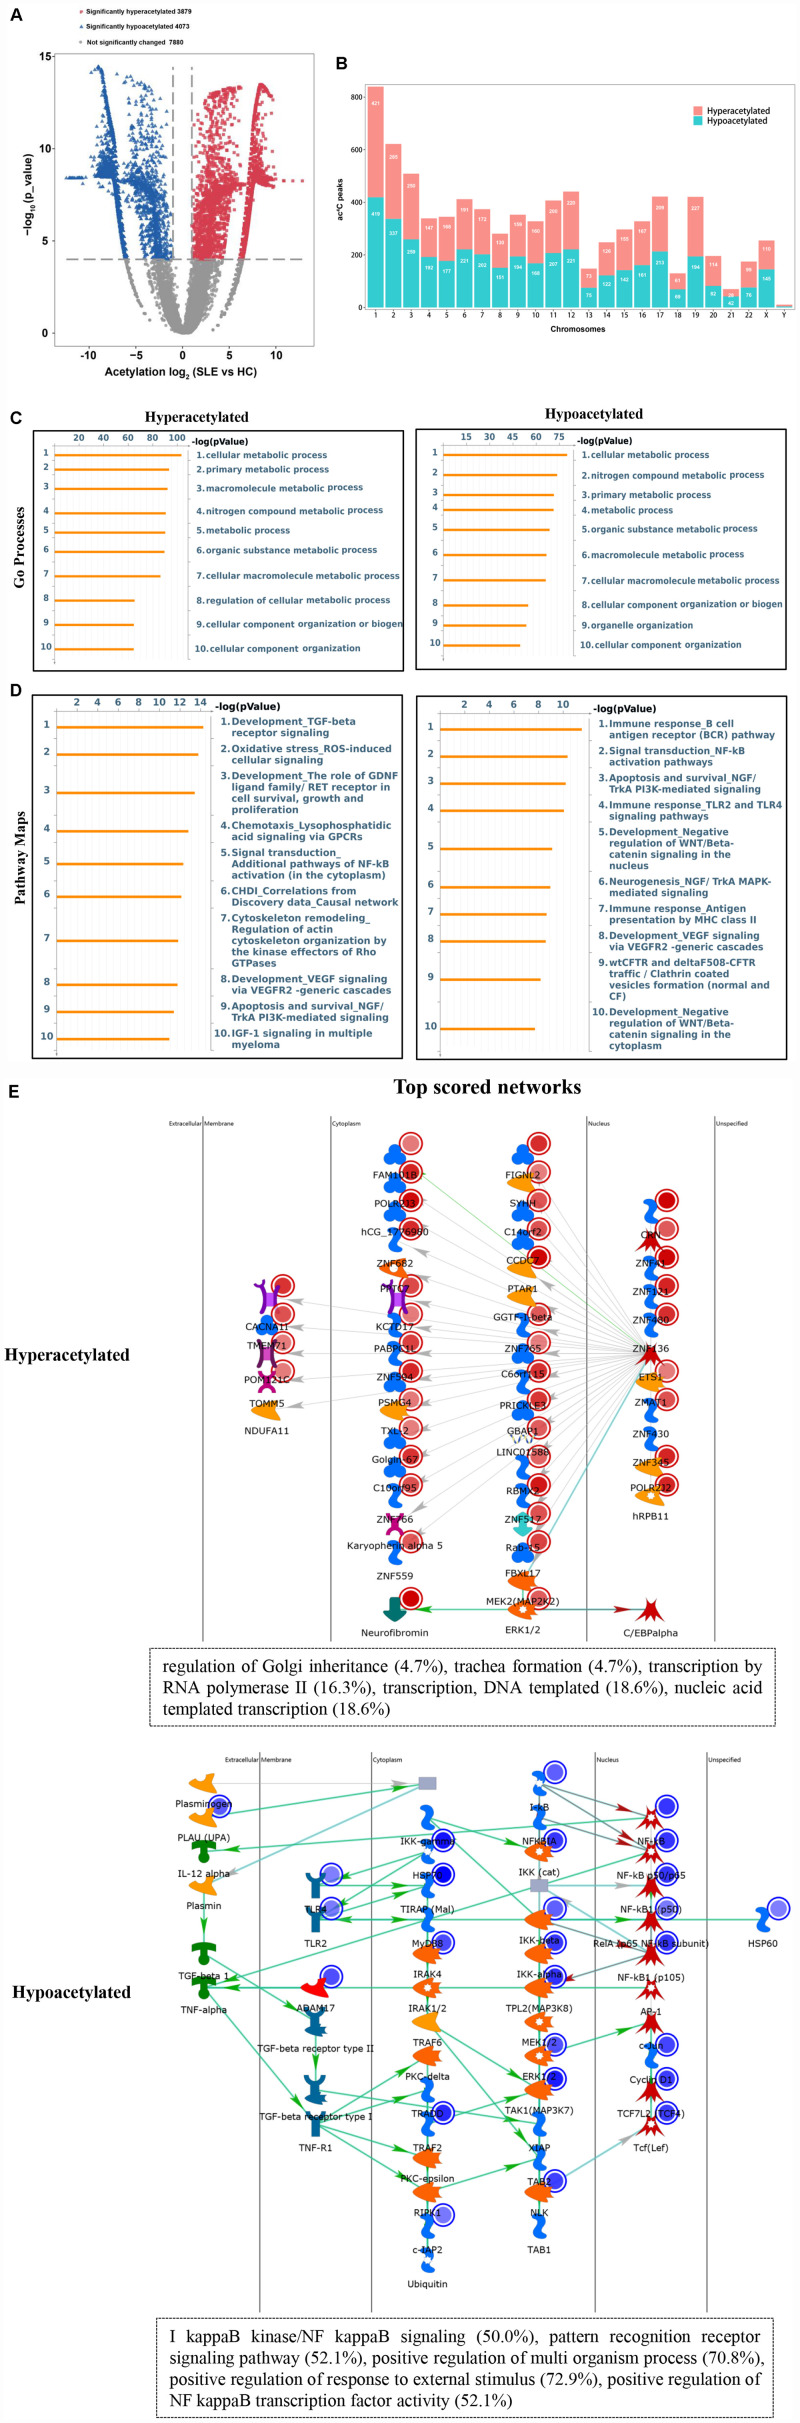
Pathway analysis of differentially acetylated genes. (A) Volcano plots display the differential ac4C peaks with statistical significance (fold change > 2; P < 0.0001). Blue points indicate significantly hypoacetylated transcripts and red points indicate significantly hyperacetylated transcripts. (B) The distributions of altered ac4C peaks in chromosomes of SLE patients. (C) Gene Ontology (GO) process analysis of differentially acetylated genes. Left panel represents hyperacetylated transcripts and right panel represents hypoacetylated transcripts. (D) Pathway Maps analysis of differentially acetylated genes. Left panel represents hyperacetylated transcripts and right panel represents hypoacetylated transcripts. (E) Top scored networks analysis of differentially acetylated genes. Top panel represents hyperacetylated transcripts and bottom panel represents hypoacetylated transcripts.